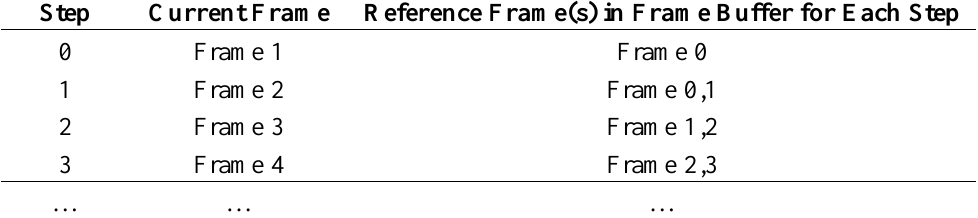
Figure 8. Processing steps of the PEA for Inter-E of